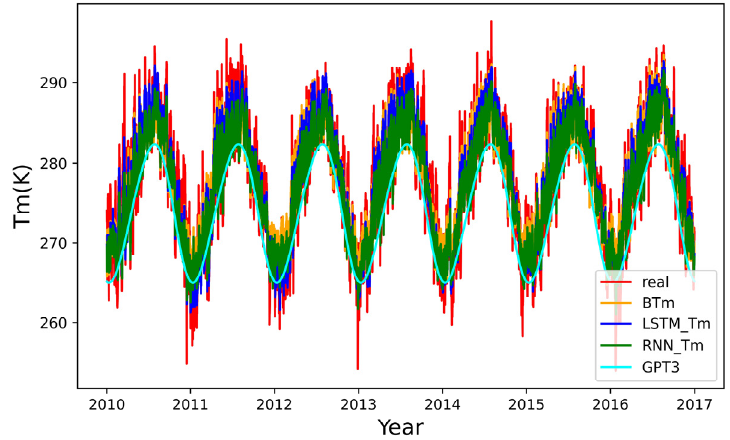
Figure 11. Tm time series calculated from four models and radiosonde observations at station 57127.